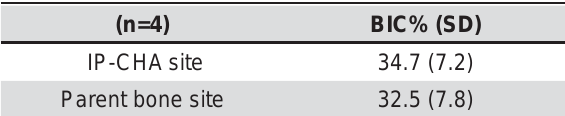
Table 1- The rate of bone-implant contact